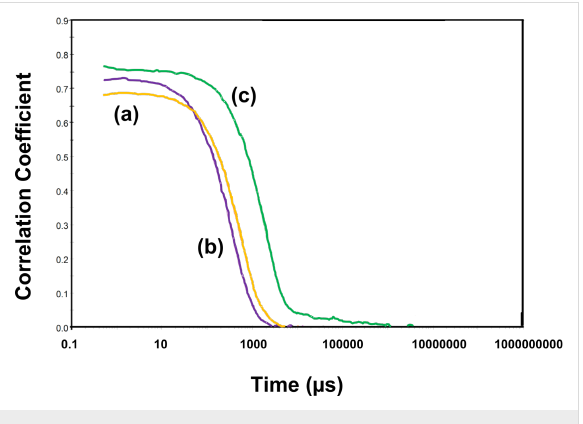
Figure 9: DLS correlation coefficient vs time for (a) P3HT:CISe (b) P3HT:CIGSe and (c) P3HT:CZTSe nanocomposites.